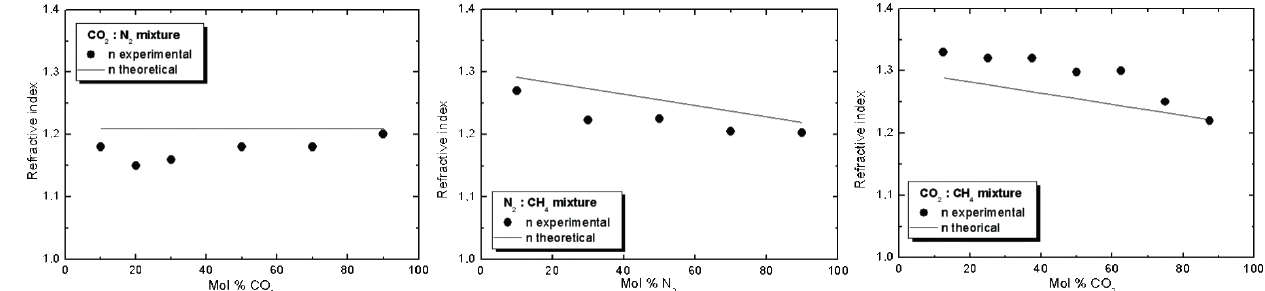
Figure 15. Refractive index values of binary mixtures for different gas-phase deposition temperatures.